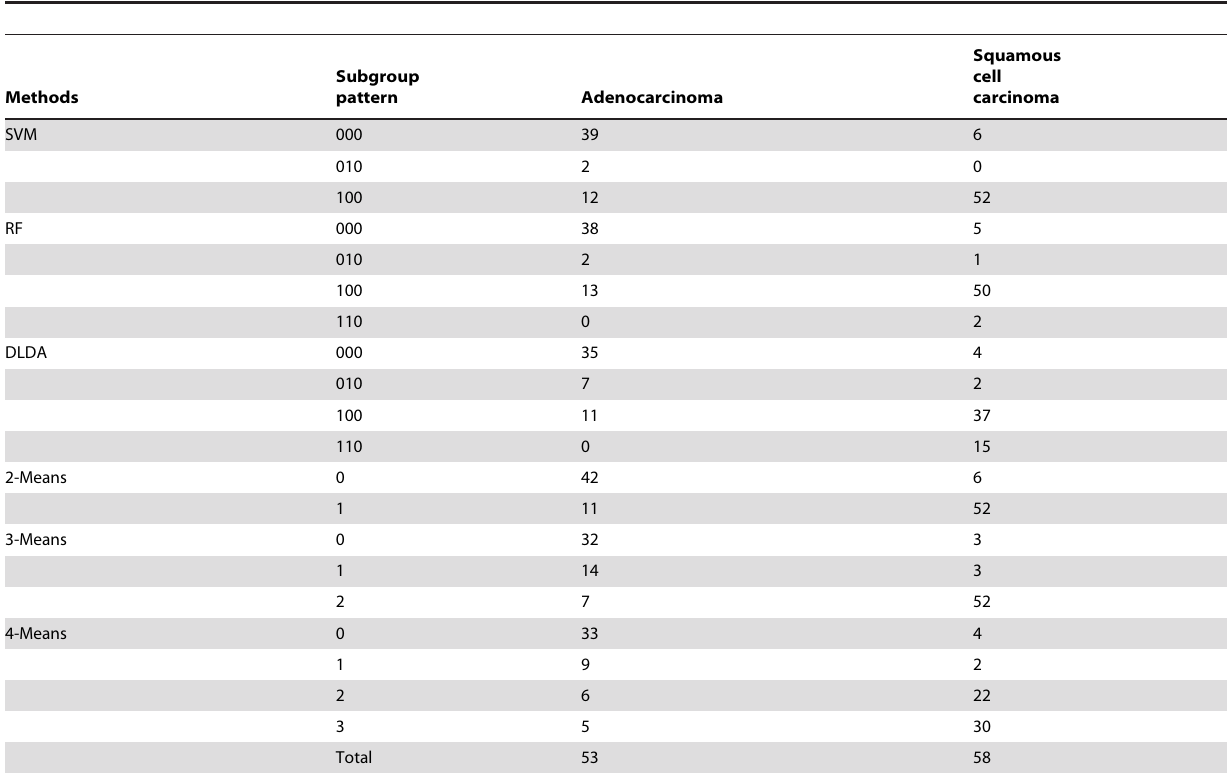
Table 2. Subgroup classification for the 111 lung cancer patients of the GSE3141 dataset using the composite model with the SVM, RF and LDA algorithms, and K-means (2-means, 3-means and 4-means) cluster analysis.